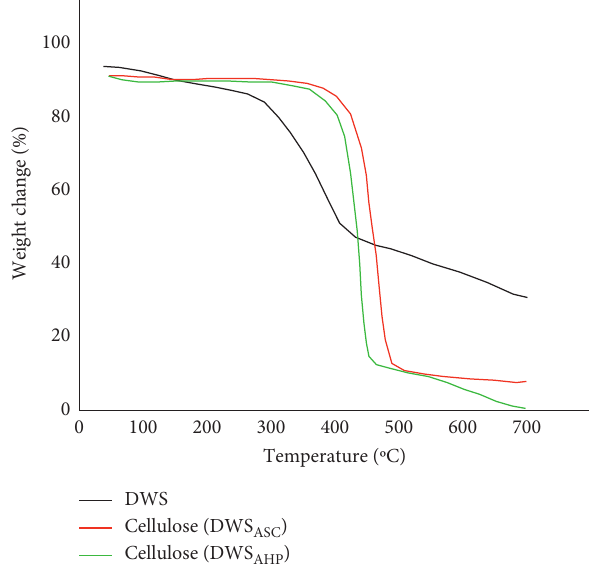
Figure 3: TGA thermograph of DWS, cellulose (DWS cellulose (DWS ASC